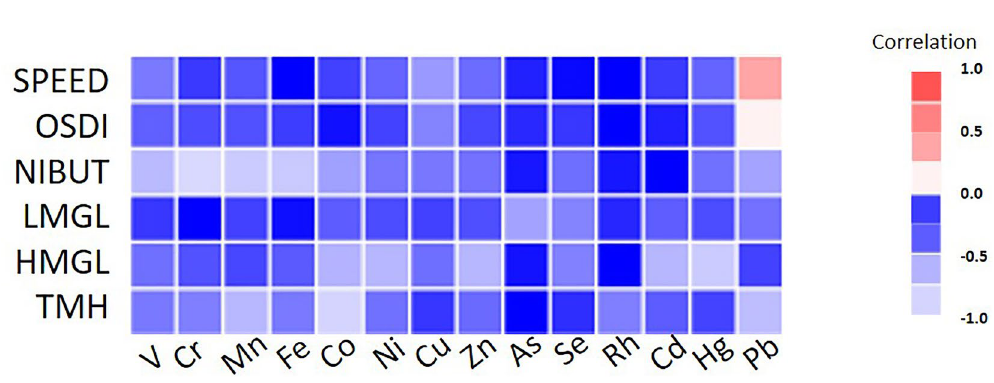
Figure 2. Heatmap illustration presents a pairwise correlation between tear trace elements and dry eye disease